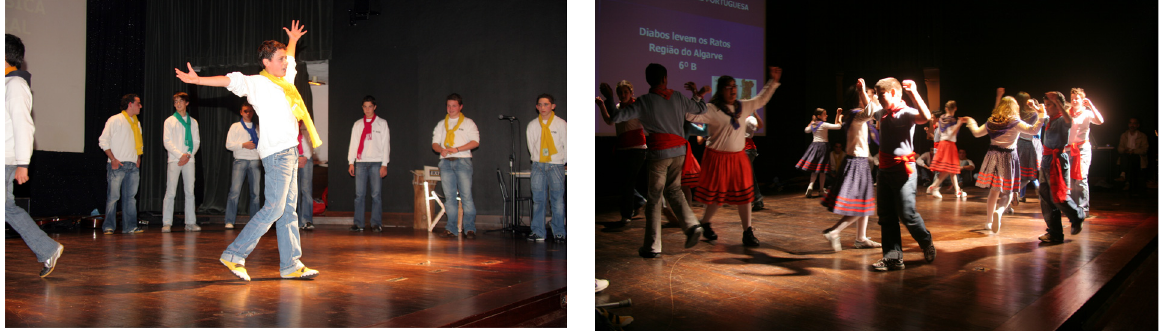
9 | Fig. 9: 9th graders expressiveness and creativity. 10 | Fig. 10: 6th graders dancing country